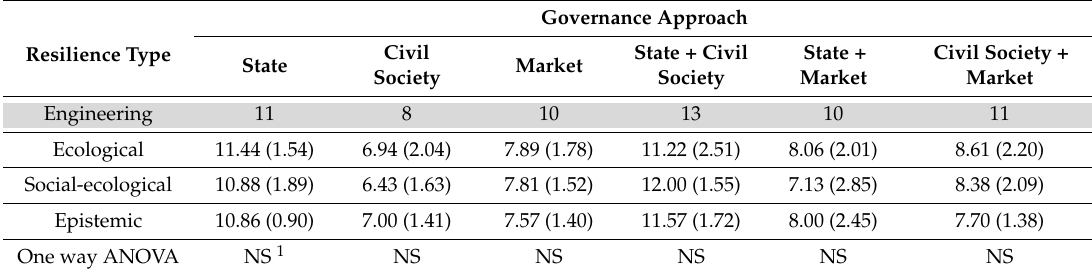
Table 2. Preferences for governance approaches for resilience type groups. Means and standard deviations (in parentheses) are